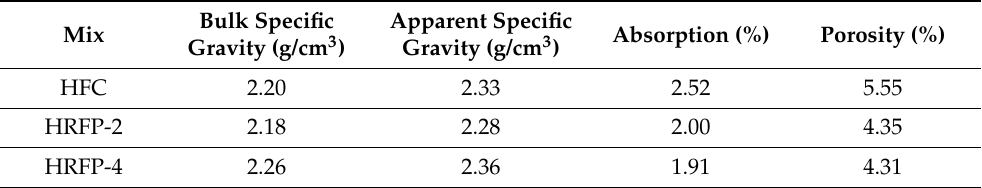
Table 5. Concrete physical